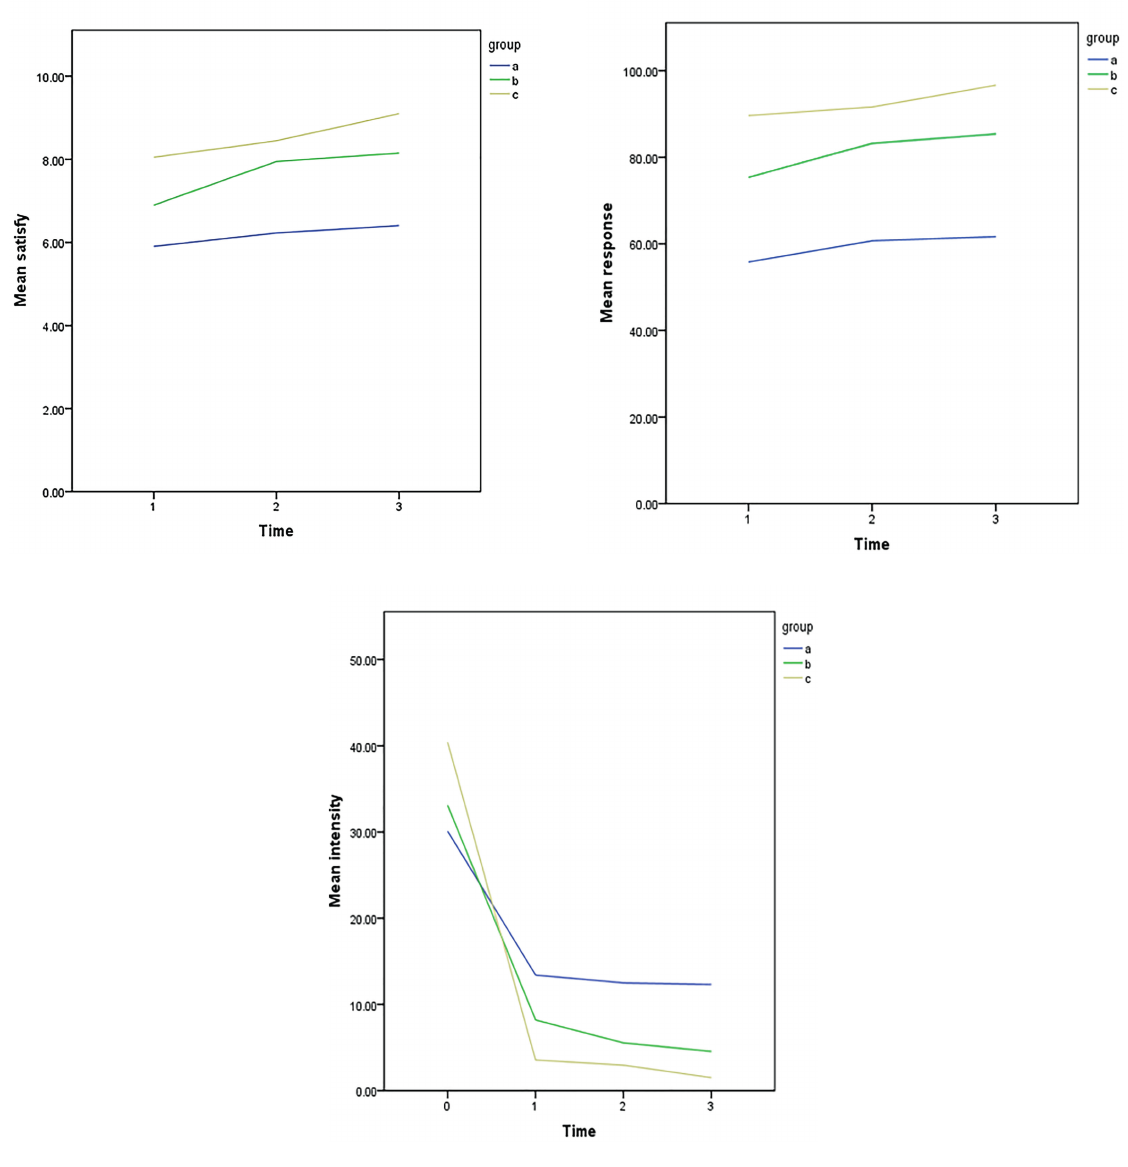
Figure 1 - Comparison of the satisfaction, response and intensity of treatment Nocturnal enuresis in a different group (right to